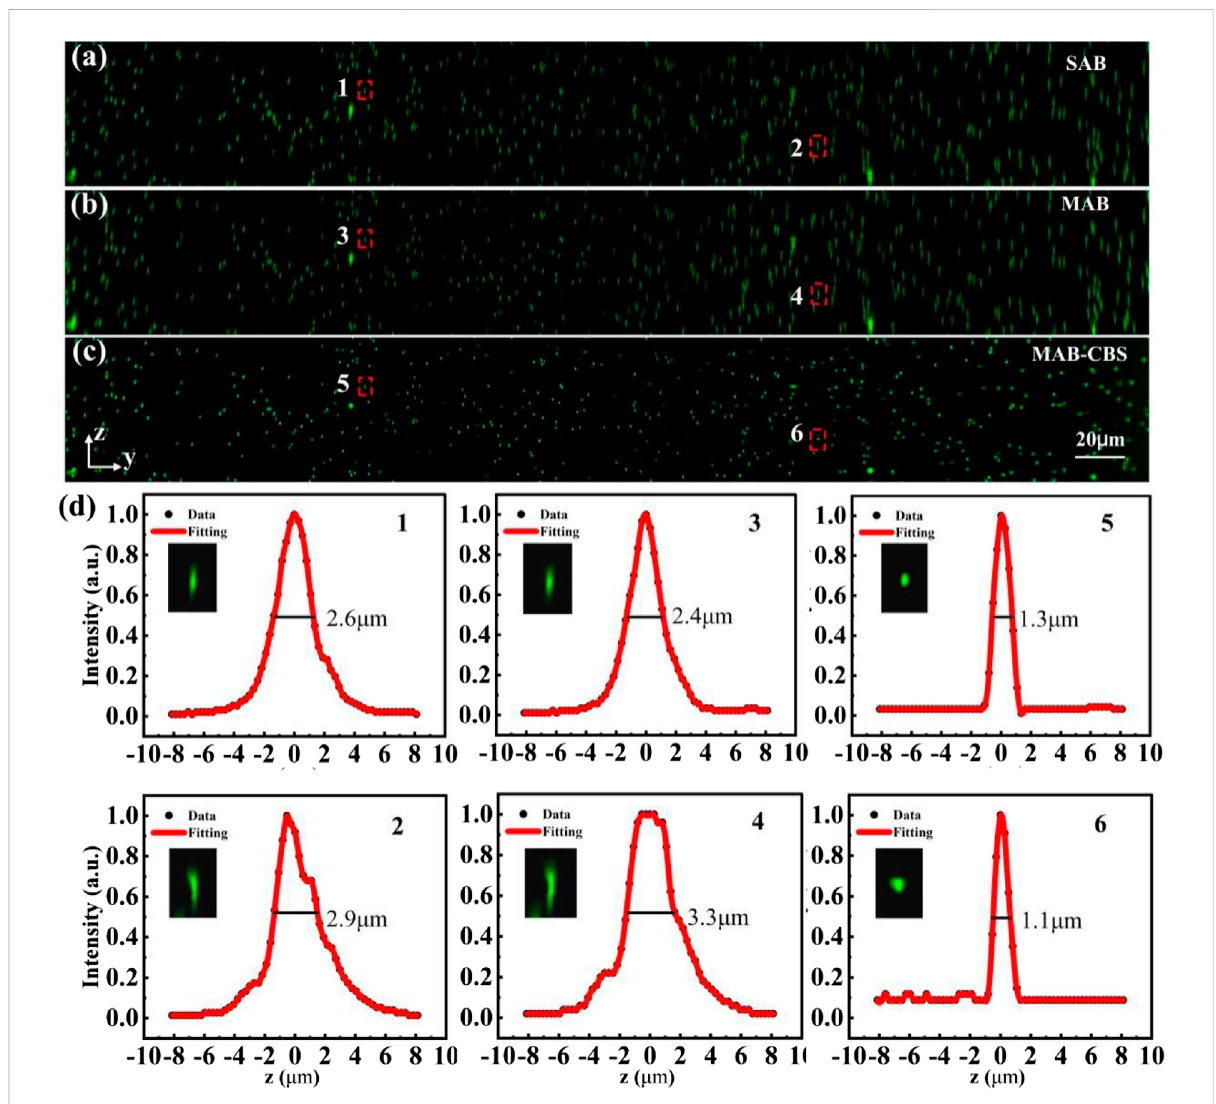
FIGURE 3 Imaging results of 500 nm-diameter fl uorescent beads. (A – C) The yz -plane maximum intensity projection (MIP) images of fl uorescent beads excited by using the SAB light-sheet, MAB light-sheet and MAB-CBS method, respectively. (D) The normalized intensity pro fi les along the z -axis of the fl uorescent beads selected in (A – C) . The insets are the magni fi ed views of the selected beads indicated by the dashed box in (A – C)